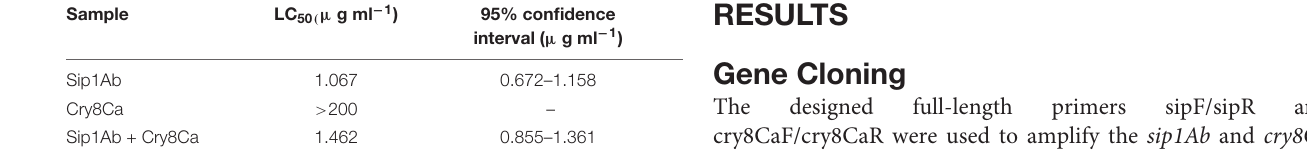
TABLE 2 | The bioassay results of Sip1Ab and Cry8Ca proteins against the Colaphellus bowringi .